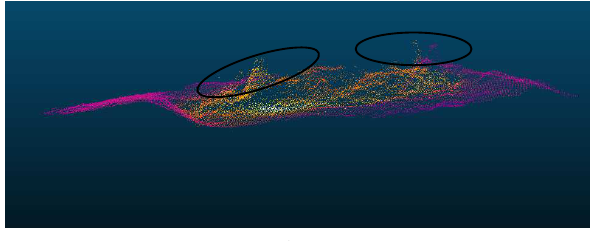
Figure 3. Side view of the thermal point cloud deviations from the expected surface.